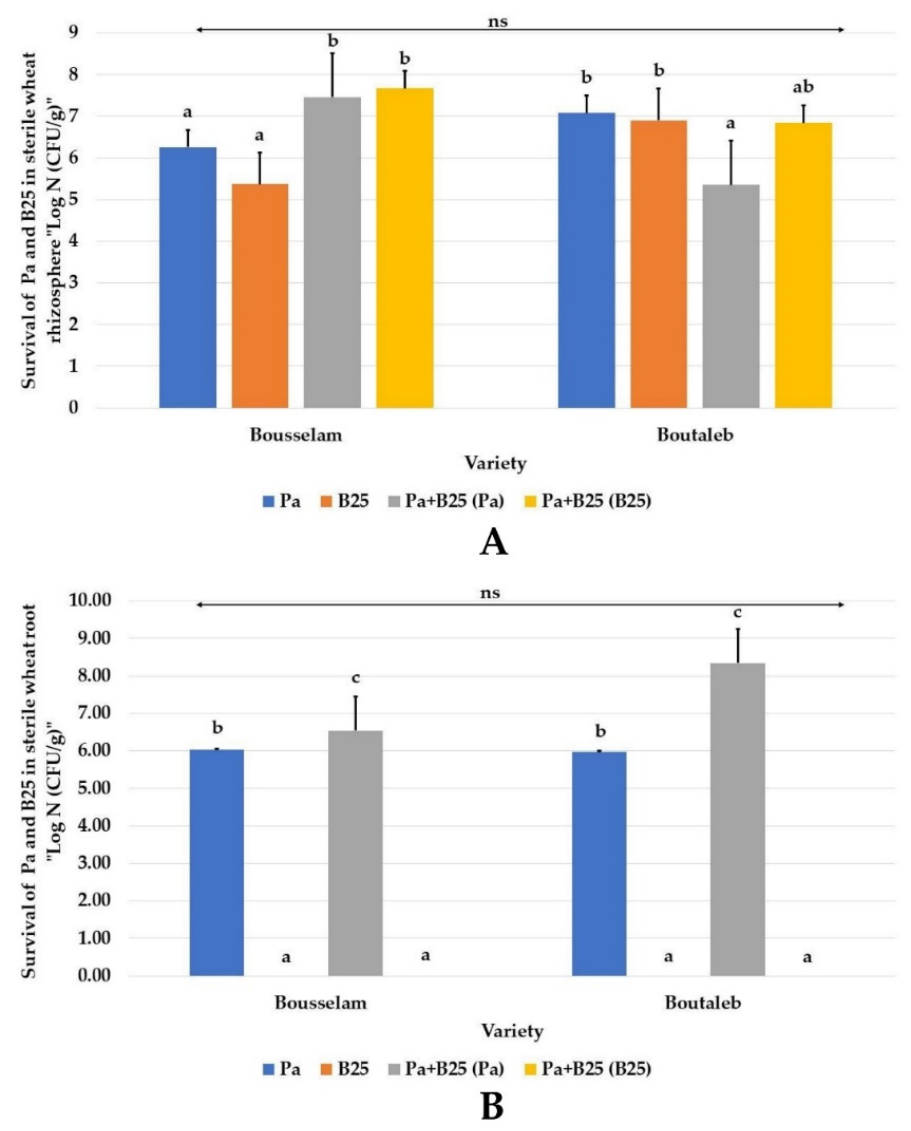
Figure 7. Survival of bacteria, Pa and B25 (Log N(CFU/g)), in ( A ) rhizosphere and ( B ) roots of wheat plants of the Bousselam and Boutaleb varieties, grown in sterile compost inoculated with Pa, B25, and Pa + B25. The bar plots represent the mean ± standard error of three different experiments. IBM SPSS Statistics v.24 was used to perform statistical analysis, using a two-way ANOVA and Tukey’s multiple comparison post-test. ns: